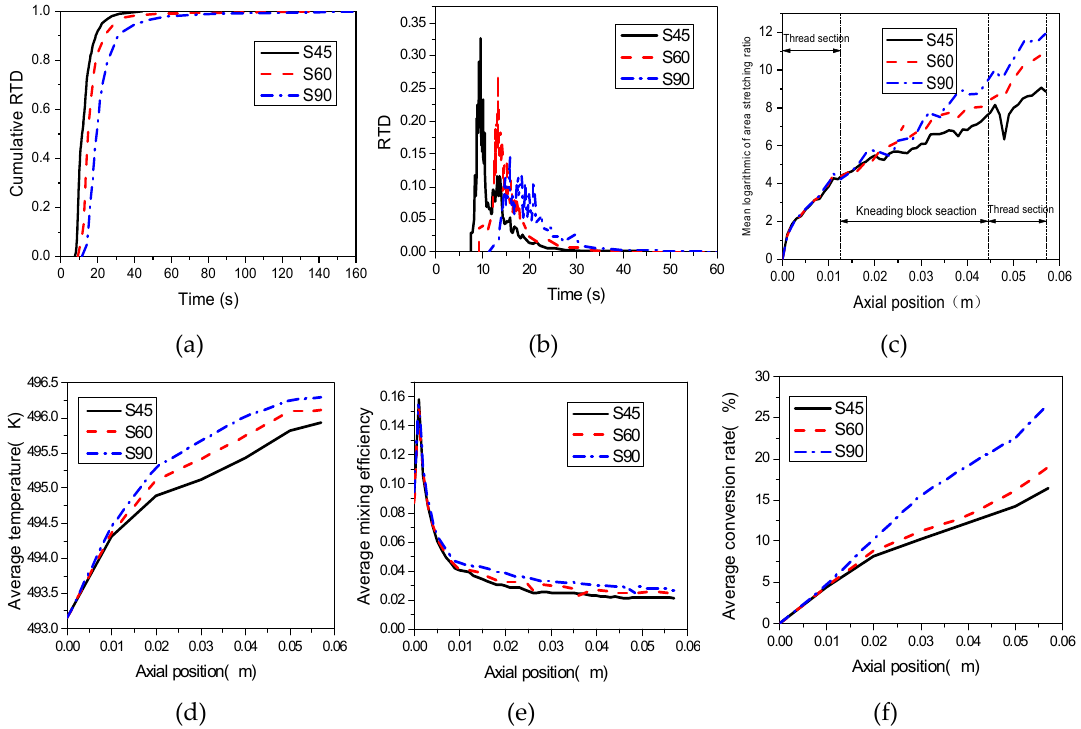
Figure 13. Effect of stagger angle on ( a ) cumulative RTD; ( b ) RTD; ( c ) logarithmic of area stretching; ( d ) mixing efficiency; ( e ) temperature; ( f ) conversion rate.